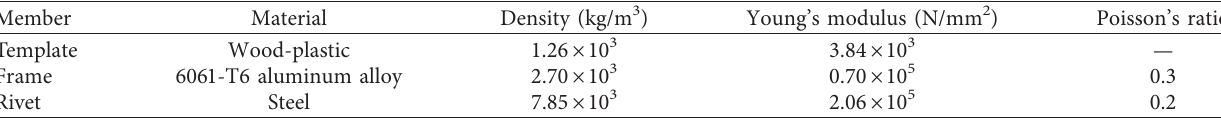
Figure 2: Geometric model of a three-span continuous formwork (Type II). (a) Model of a frame without a template. (b) Model with a template. (c) Dimensions of the formwork. (d) Sections of ① and ② . (e) Sections of ③ and ⑤ . (f) Section of ④ . Table 1: Material properties of the composite wood-plastic formwork.